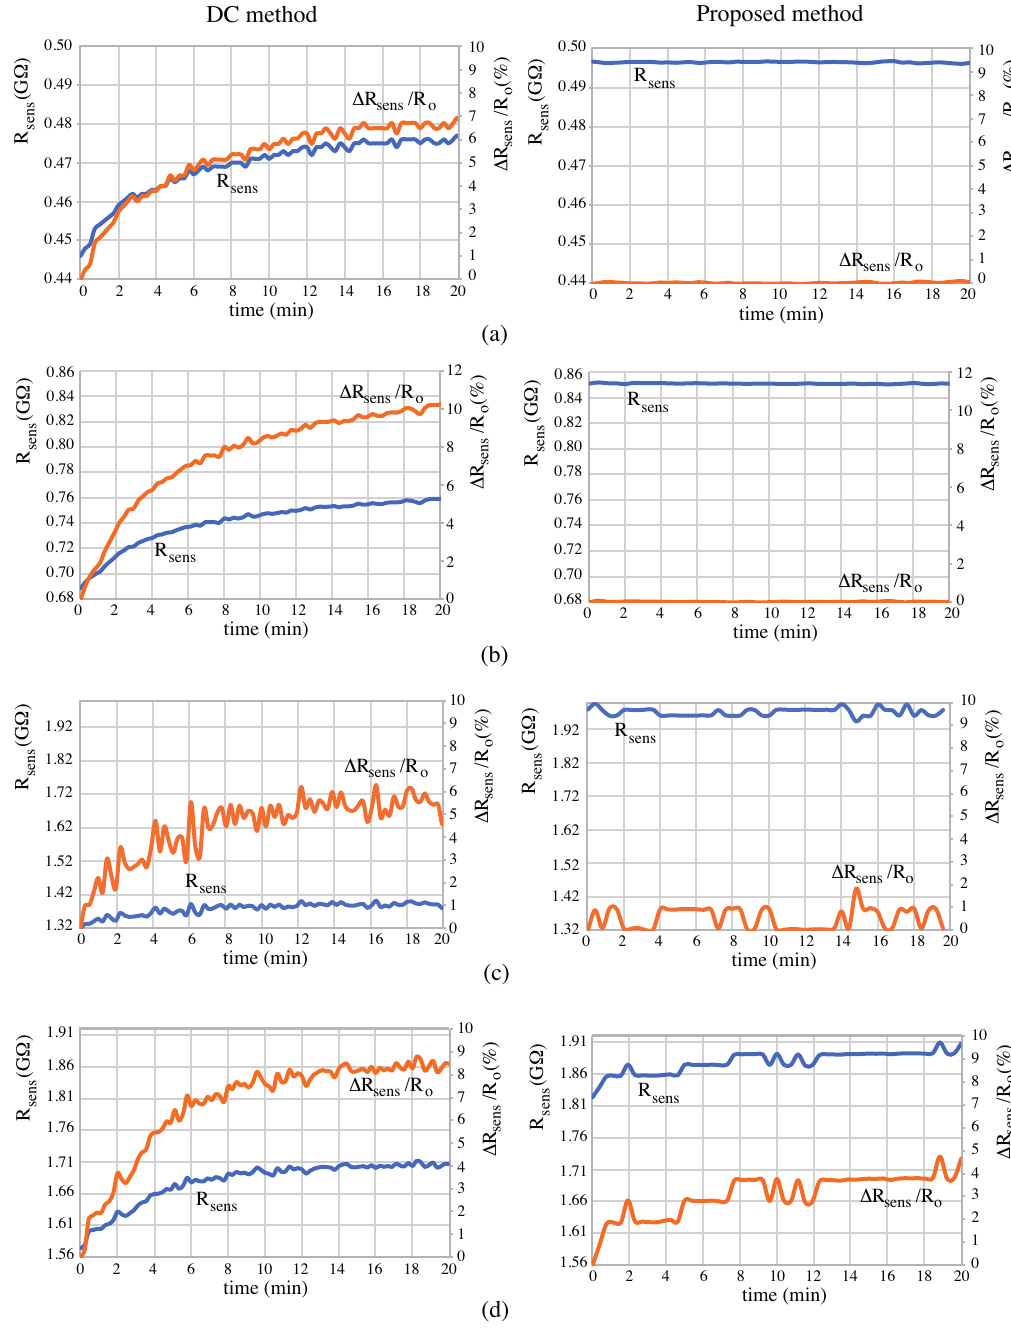
Figure 5. Experimental results for transient measurement values by the proposed method (right column) and Direct Current (DC) method (left column) for: ( a ) Douglas-fir, ( b ) Sweet chestnut, ( c ) Maritime pine, ( d ) European